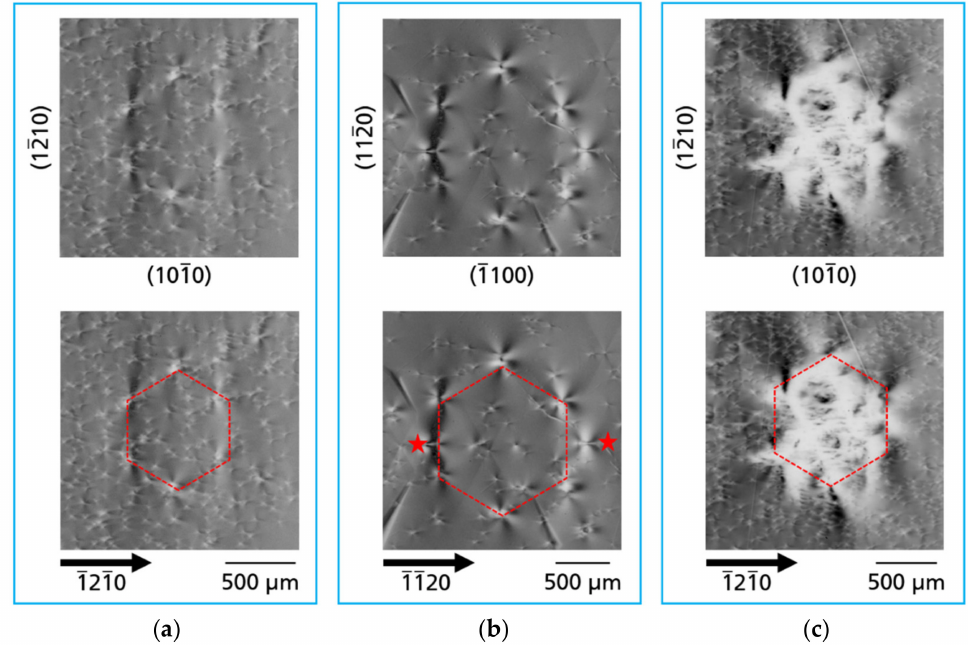
Figure 13. Honeycomb defects formed by a hexagonally arranged cluster of DBs; ( a ) perfect hexagonal honeycomb defect; ( b ) honeycomb defect with clearly formed bright and dark rosette contrasts of the DBs, two additional DBs (marked by stars) nestled into the arrangement of the hexagon; and ( c ) highly distorted variant of the honeycomb defect with distorted inner center showing nearly no Borrmann effect, named cauliflower defect. For the imaging of the topographs type 1120 reflections were